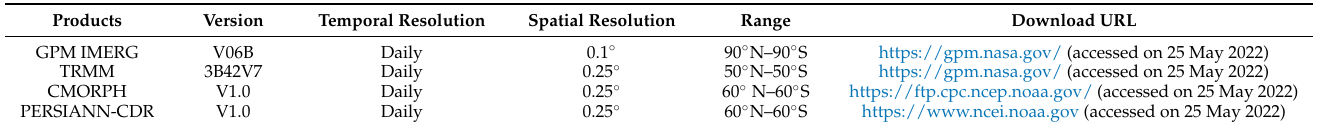
Table 1. Summary of the satellite precipitation datasets used in this study.